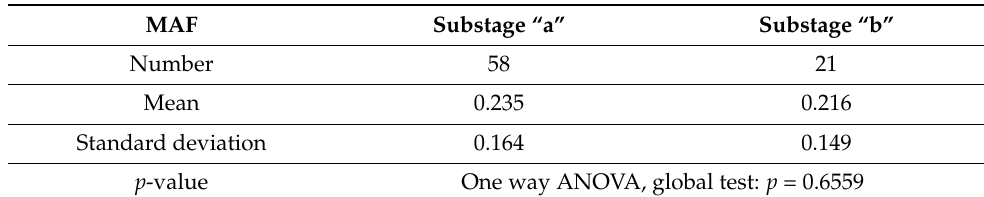
Table 6. A comparison of the MAF values in different